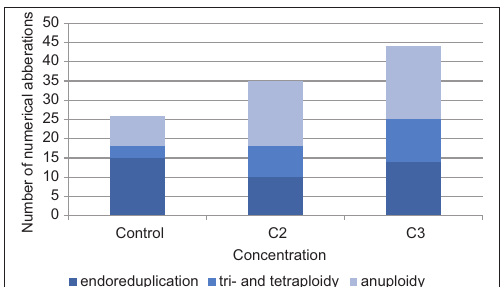
FIGURE 2. Frequency of numerical Aberrations. Cell culture C2 was incubated with met‑enkephalin and alpha‑ACTH 1‑13, in concentrations of 1.2 µg/ml and 0.24 µg/ml, respectively, while C3 was incubated with met‑enkephalin and alpha‑ ACTH 1‑13, in concentrations of 120 µg/ml and 24 µg/ml, respectively. The mitotic index was determined as the percent of lymphocytes in mitosis (M1 + M2) scored to 300 lymphocytes (Table 2).